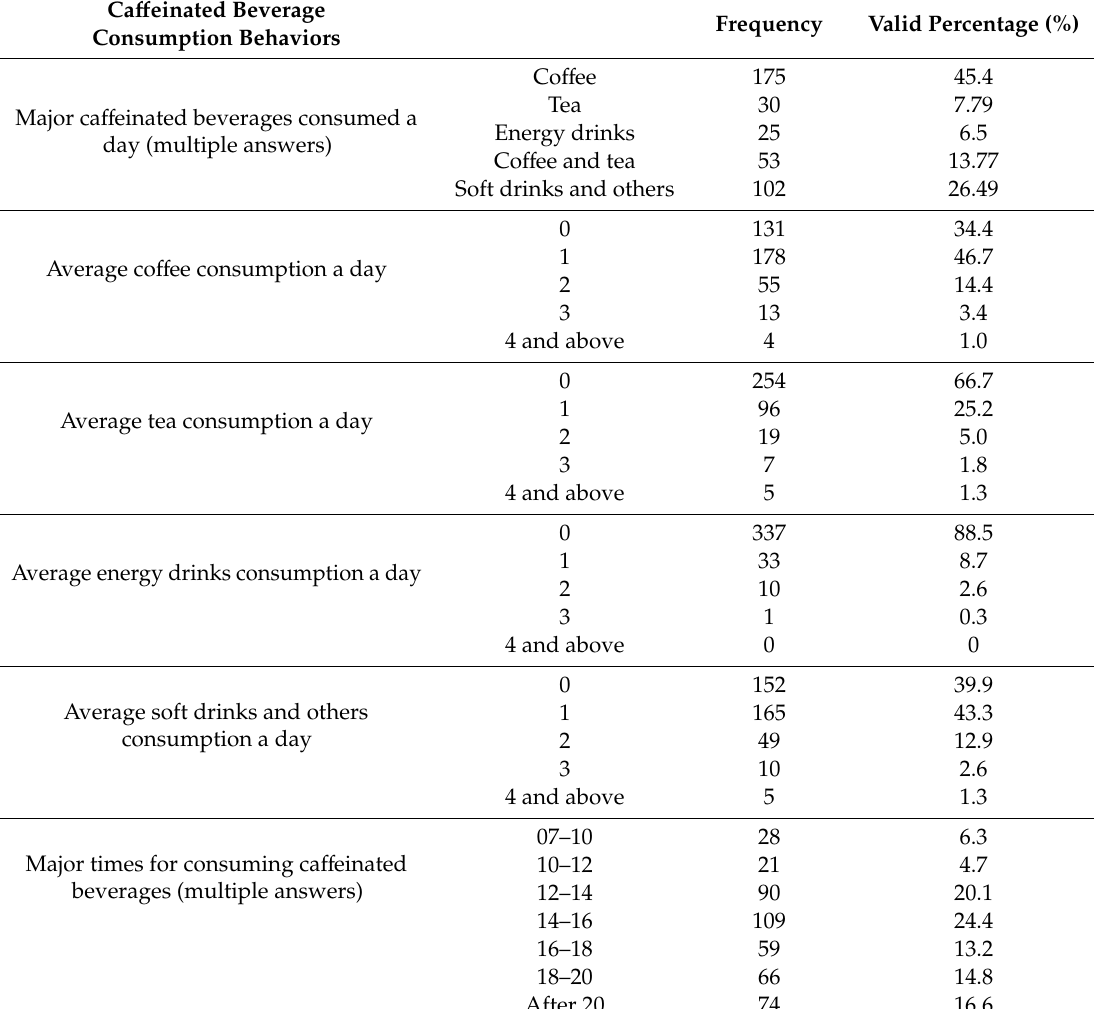
Table 2. Characteristics of the respondents regarding their ca ff einated beverage